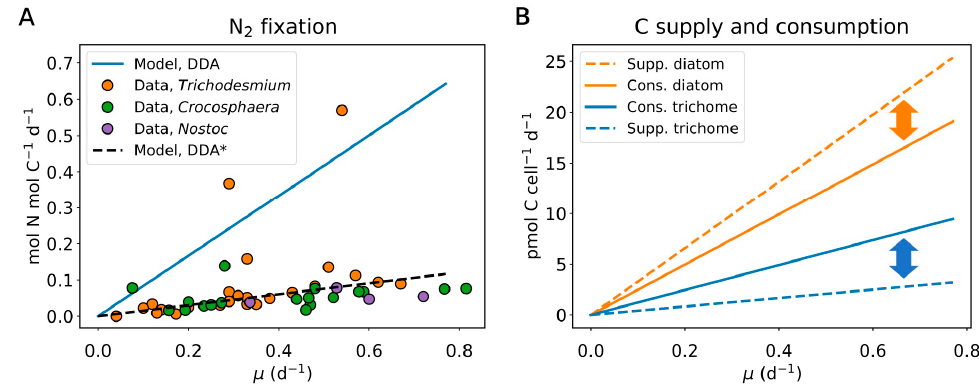
Figure 2. Rate of N 2 fixation and the balance of C supply and consumption. ( A ) Rate of N 2 fixation per C in the trichome. In the legend, “Model, DDA” indicates model results for DDA. “Model, DDA*” is model ignoring N 2 fixation for diatom. “Data Trichodesmium” , “Data Crocosphaera”, and “Data Nostoc” are data for Trichodesmium [32,33,54], Crocosphaera [6,34,35,55,56], and Nostoc [57], respectively. ( B ) Predicted balance of C supply and consumption. Supp. and Cons. indicate “supply from” and “consumption by”, respectively. The arrows are to point out the supply–demand discrepancies.